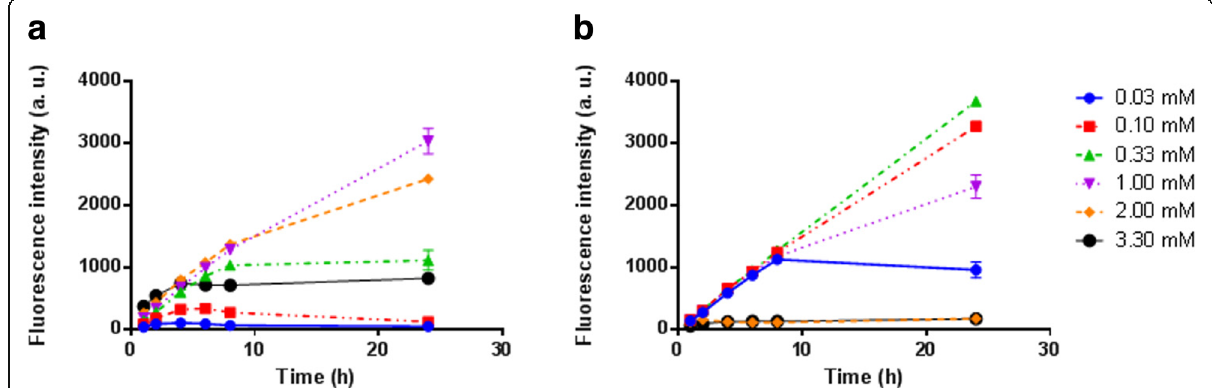
Fig. 4 Kinetic fluorescence measurements of PpIX accumulation in PC3 cells. The cells were incubated with increasing concentrations of 5-ALA-SQ NAs ( a ) or 5-ALA-Hex ( b